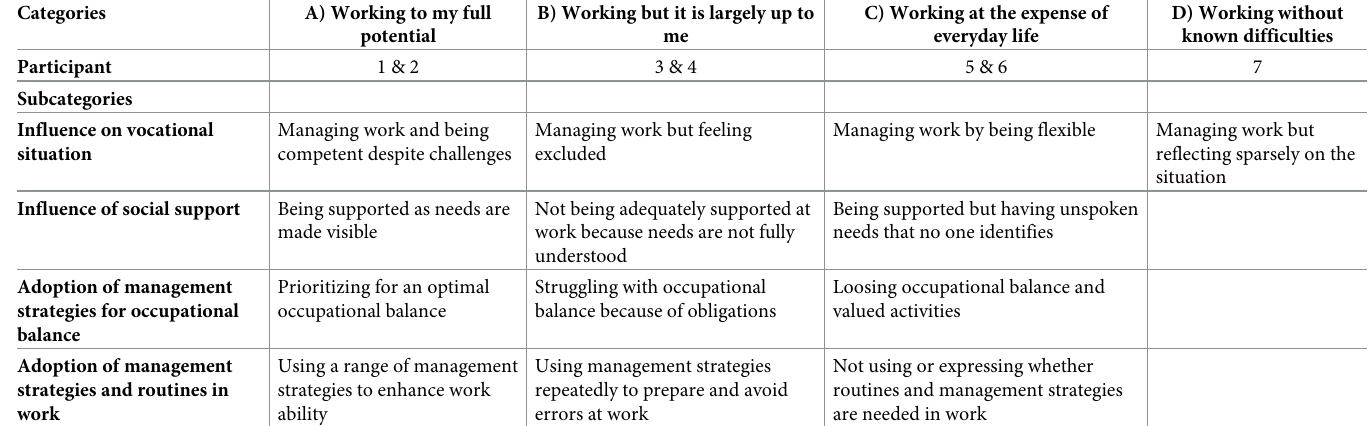
Table 2. Categories describing how the participants with subjective cognitive difficulties (n = 7) performing digital work tasks experienced their vocational situa- tion and how the situation influenced their everyday life.